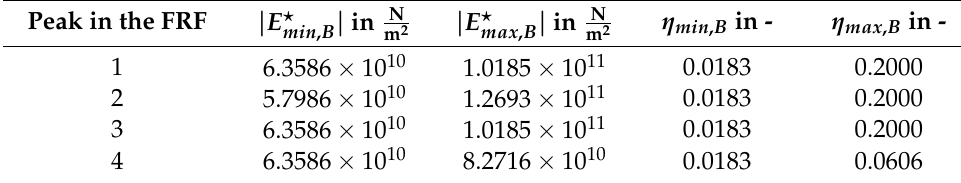
Table 4. Limit values obtained from the bisection process.